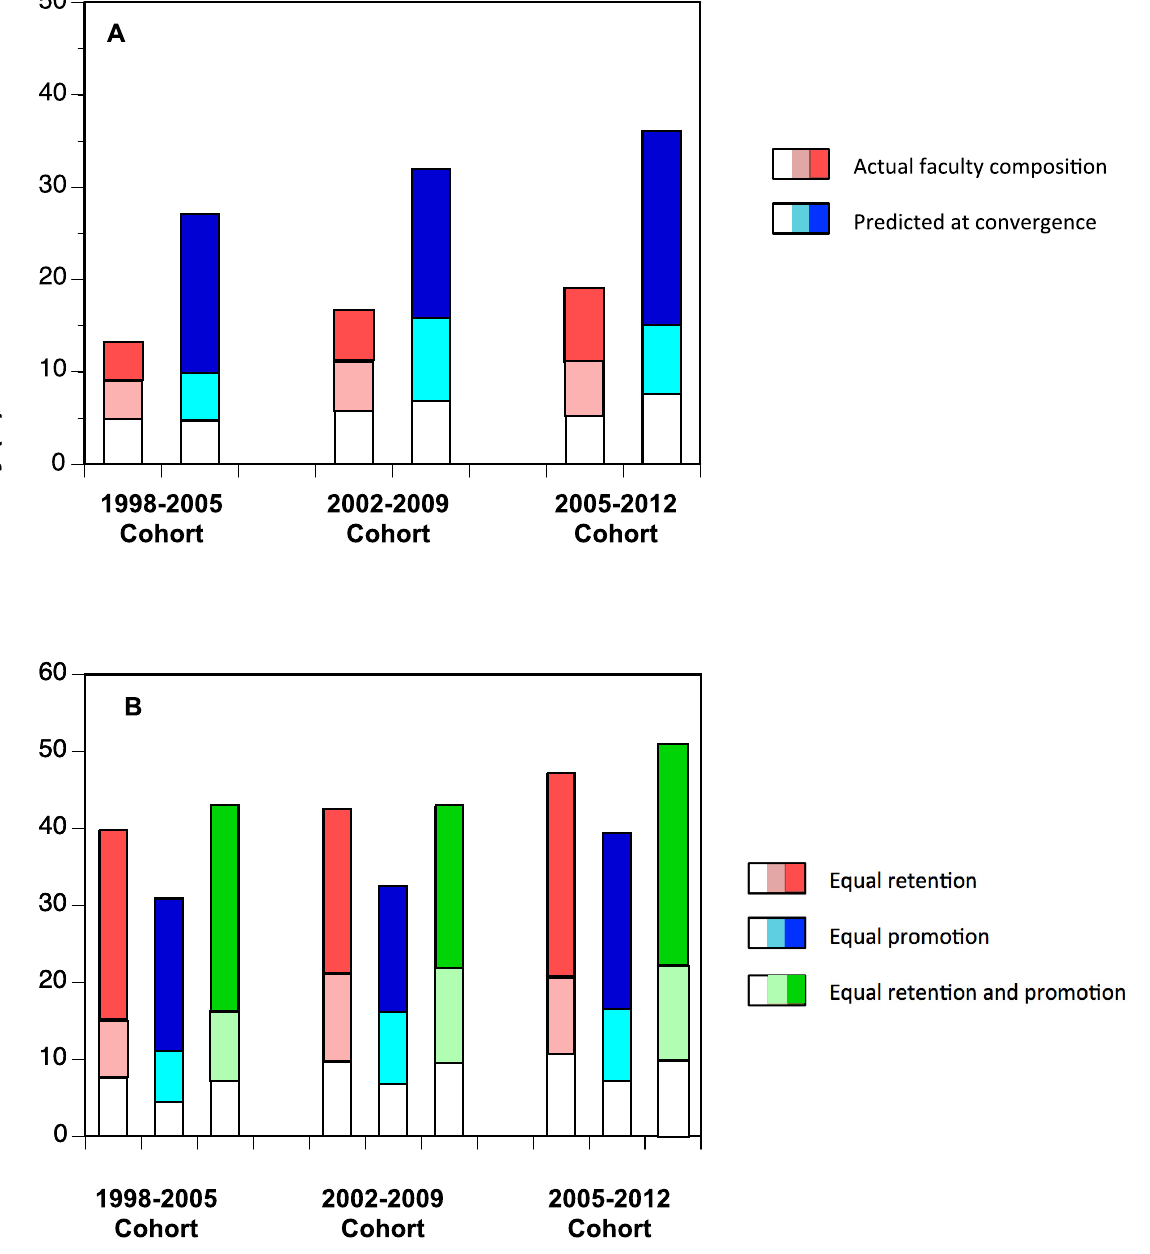
Fig 4. Results of simulations. For all bars, the bottom (white) segment represents Assistant Professors, with Associate Professors above them and Professors as the top segment. A) Actual representation of women on the faculty (red) and convergent state (blue), given the respective transition matrix. B) Simulated convergence states under the assumption that recruitment of Assistant Professors is 50% women (red); 2) retention of male and female Assistant Professors is equal (blue); or 3) both recruitment and retention of Assistant Professors is equal